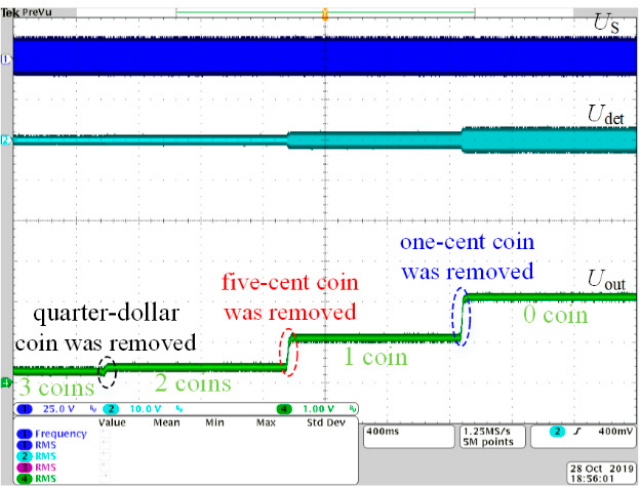
Figure 23. Waveforms of detection circuits when three coins were sequentially removed.